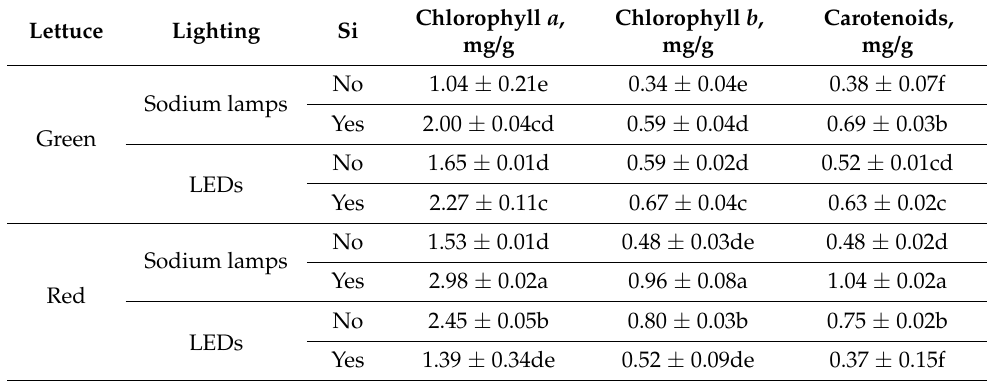
Table 2. Average concentrations of photosynthetic pigments in green and red lettuce ( Lactuca sativa L.) under conditions of a regulated agroecosystem on the 15th day of cultivation. Values represent mean ± SE ( n = 12). The different letters indicate significant differences among treatments means non-significant differences among treatments according to Duncan’s test ( p ≤ 0.05).